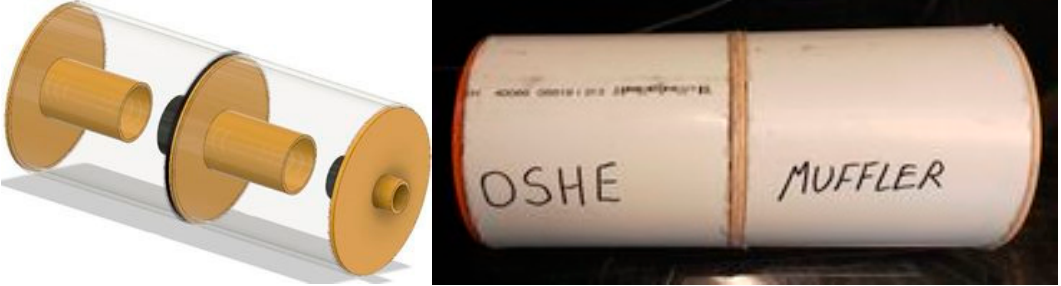
Figure 9. Comparison between computer aided design (CAD) of chamber and finished expansion chamber.